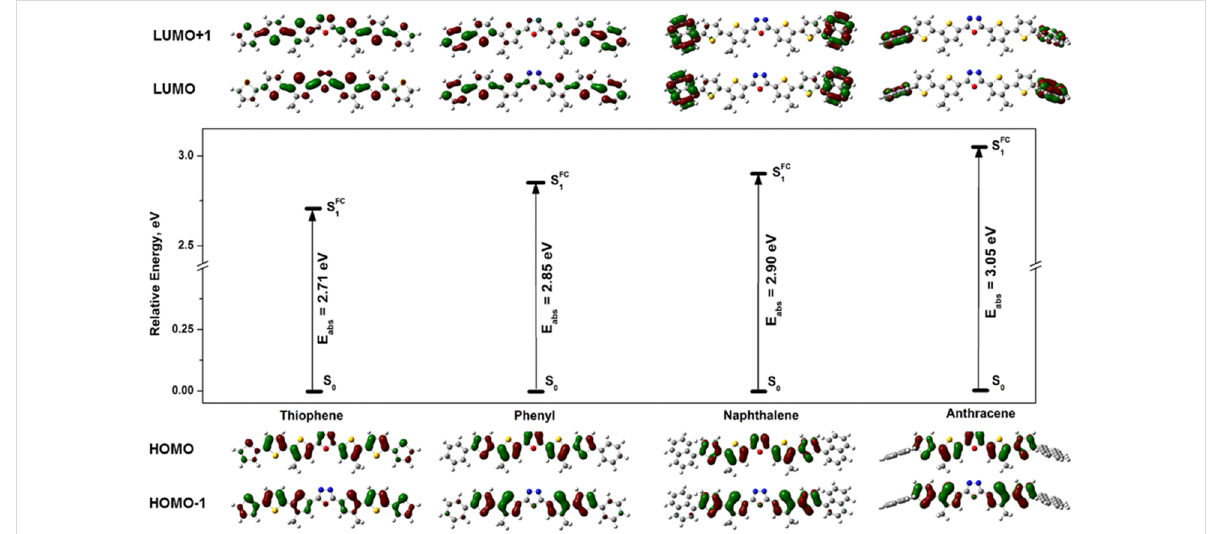
Figure 4: Frontier molecular orbitals (HOMO − 1, HOMO, LUMO and LUMO+1) and values for HOMO–LUMO band gaps of the investigated mole- cules calculated at the IEFPCM(DCM)-CAM-B3LYP/Def2-SVPD level of theory. The isovalue of each depiction is equal to 0.03 e/au 3